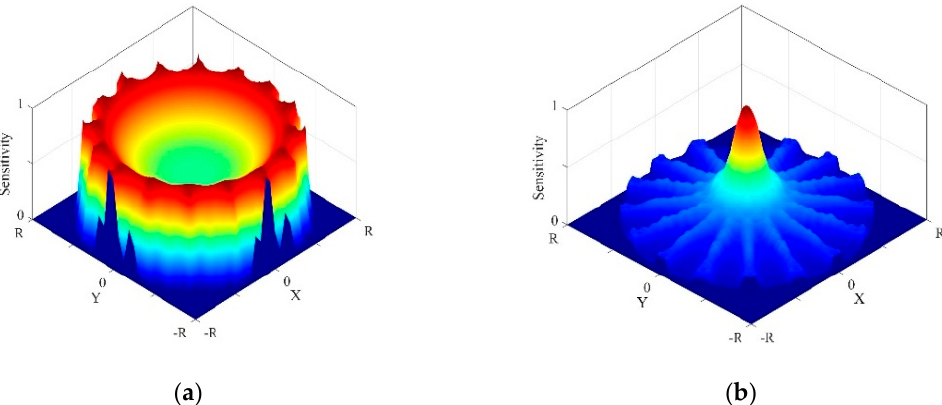
Figure 2. 3-D sensitivity distribution: ( a ) Electrical impedance tomography (EIT), ( b ) ultrasound tomography (UT).